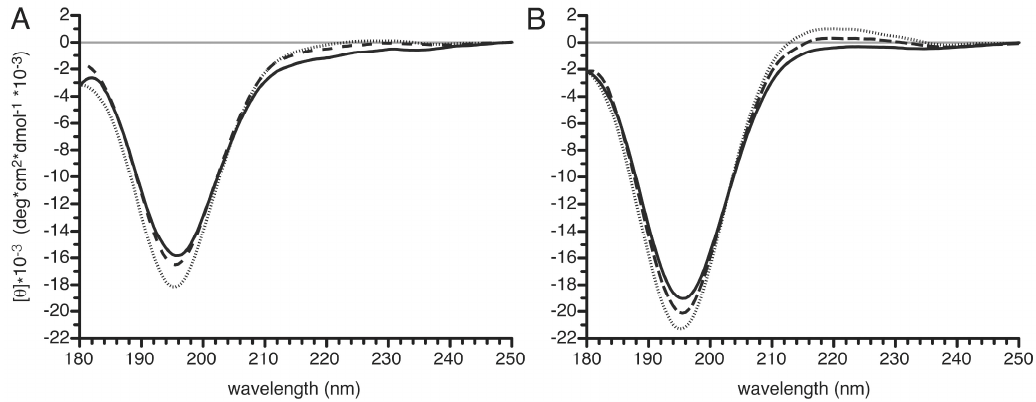
Figure 7. Circular dichroism (CD) spectroscopy of P. vulgaris TIP3;1 amino termini. CD spectra were recorded with peptides at 87 μ M in buffer of pH 7.0 in 5 mM sodium phosphate. Samples were maintained at 5, 15, or 25 °C (dotted, dashed, or solid line, respectively). CD signal shown in units of molar ellipticity [ θ ] (deg cm 2 /dmol). ( A ) CD spectra of unphosphorylated peptide aTIPnt14 exhibited strong negative ellipticity ( − 15,800 deg cm 2 dmol − 1 ) at 195 nm at pH 8 that intensified to − 18,200 deg